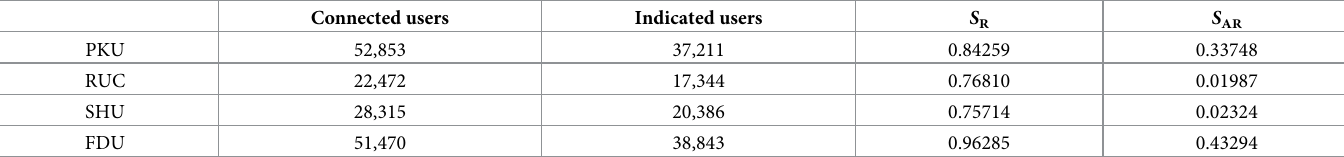
Table 1. The Rand index S R and adjusted Rand index S AR for comparing the community structure of reply networks to the polarization of users according to their preferred boards. Connected